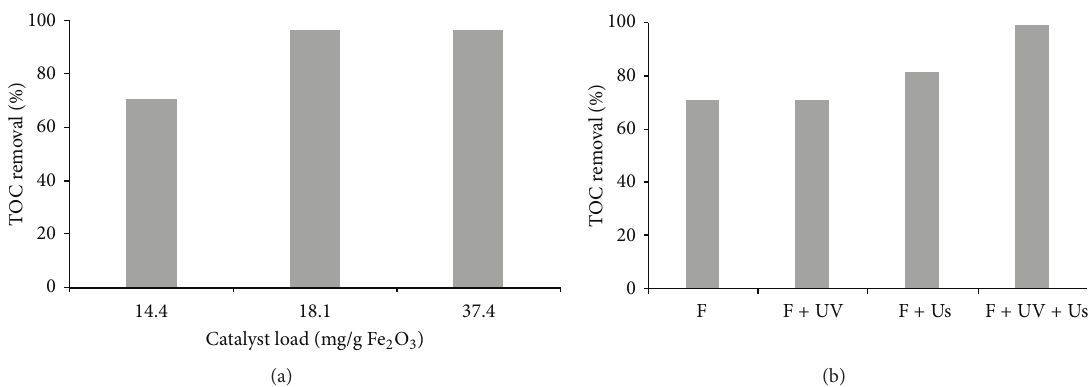
Figure 2: TOC removal of AG50 at 40 min reaction time as a function of different iron contents during the Fenton process (F) (a) and its combinations (b) with UV light and ultrasound (Us), using 100 mgL −1 of catalyst (with 14.4 mg of iron/g catalyst).